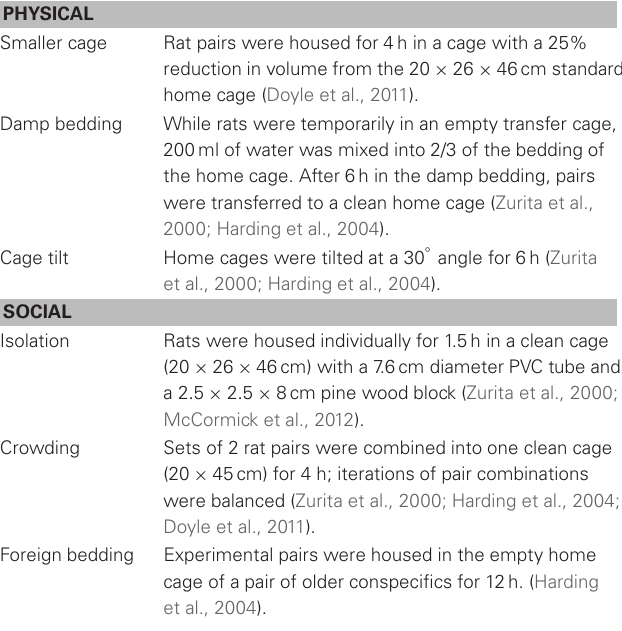
ADOLESCENT CHRONIC UNPREDICTABLE STRESS Table 1 | Chronic unpredictable stressor